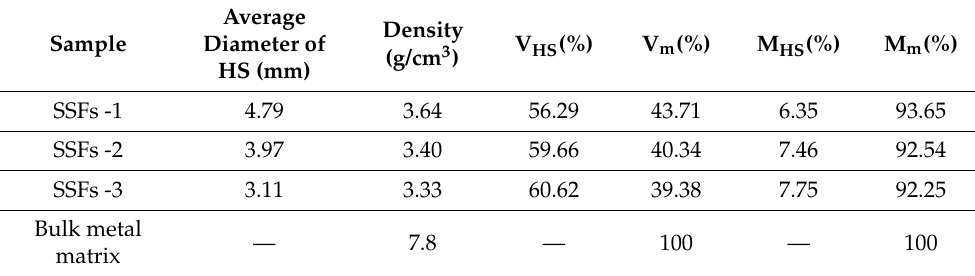
Table 2. The density of the produced SSFs and the matrix, the volume, and mass fraction of HS and